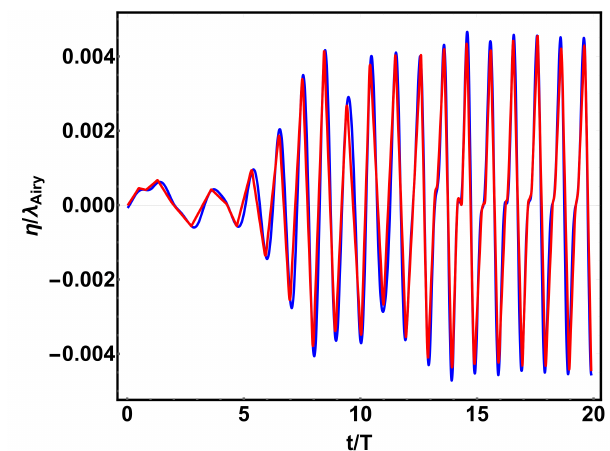
Fig. 2. The elevation of the free surface at the measurement point lo- cated downstream upstream: obtained with the use of new equation - blue line, (b) obtained from the numerical simulations presented in [14] - red